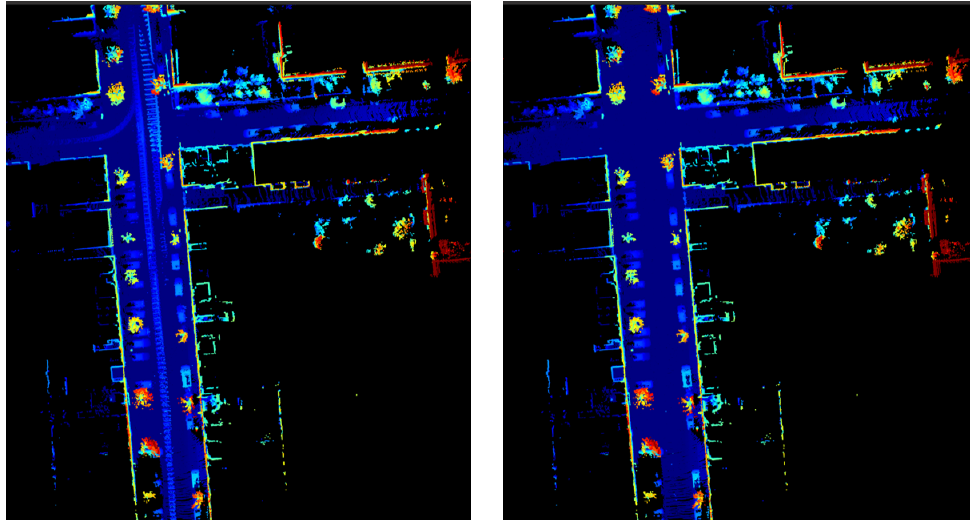
Figure 1. The left image shows the original point cloud map, where moving cars leave long trails on the map. The right image shows the result after running the proposed MapCleaner on the left image, where most of the moving objects are removed. Points are colored according to the height